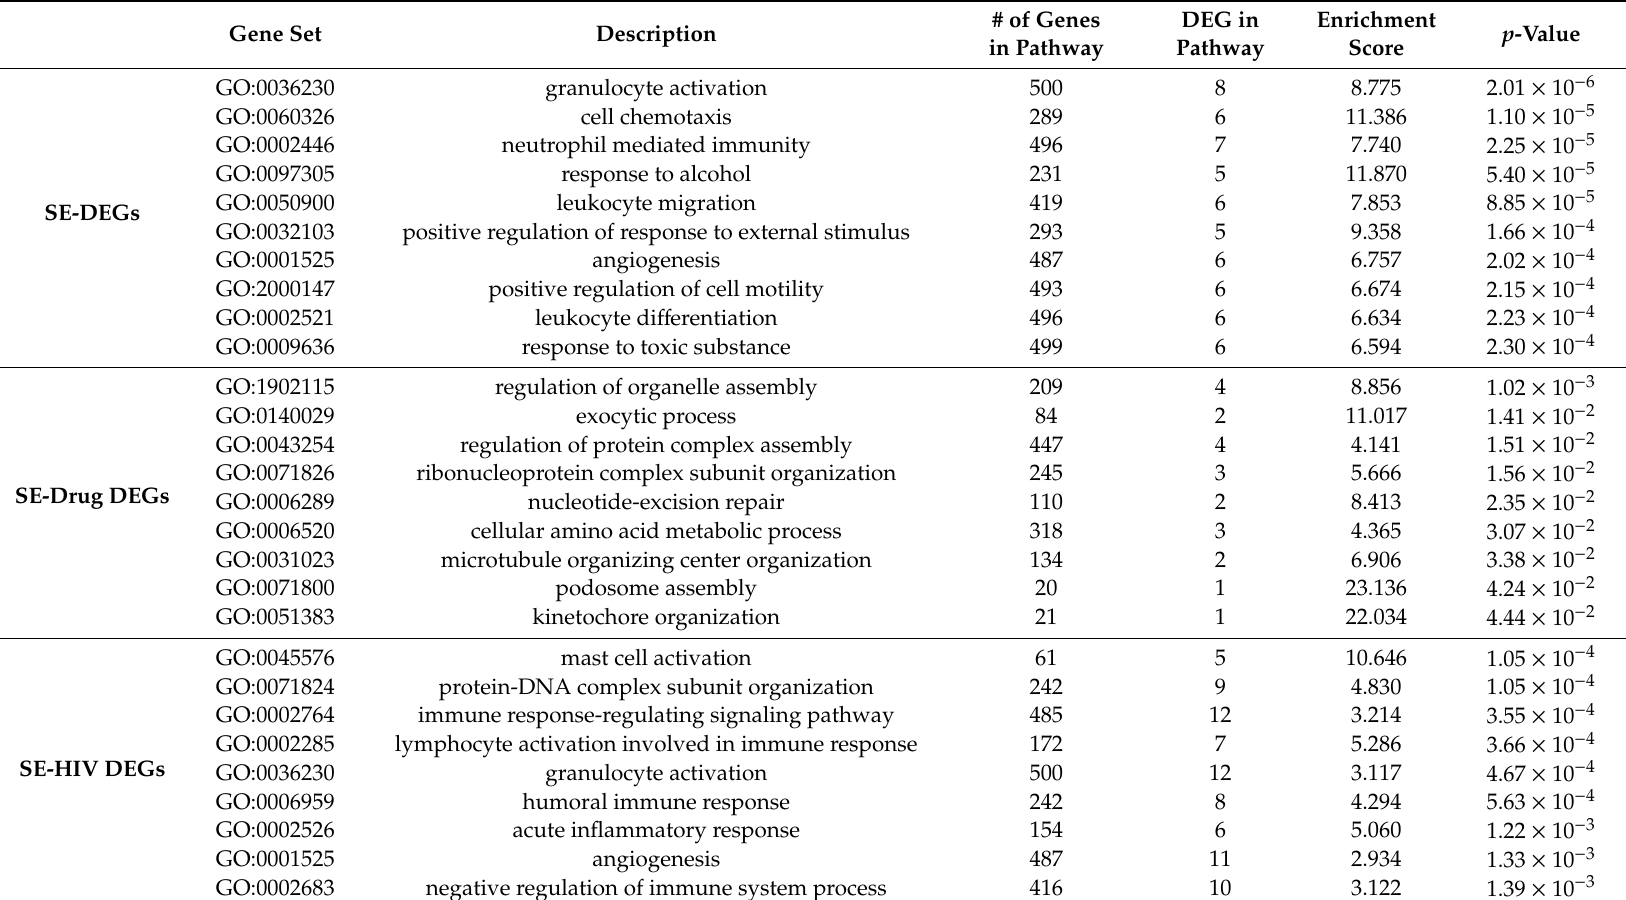
Table 4. Top 10 biological process GO terms from Webgestalt analysis 1